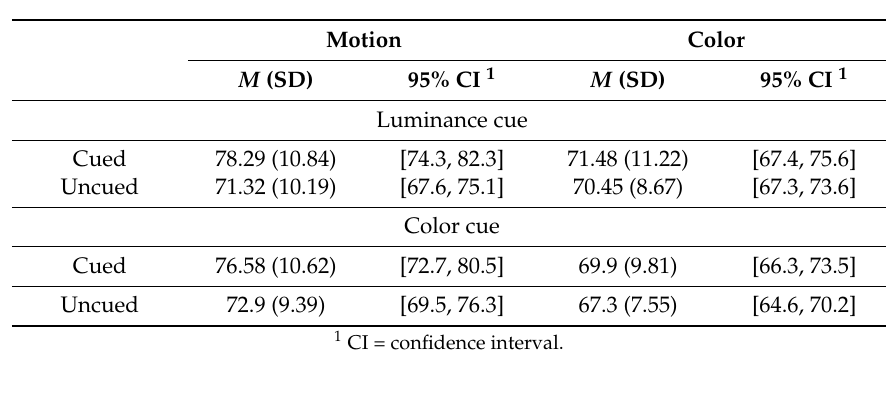
Table 1. Mean accuracy (%) for motion discrimination and color discrimination tasks on cued and uncued trials.